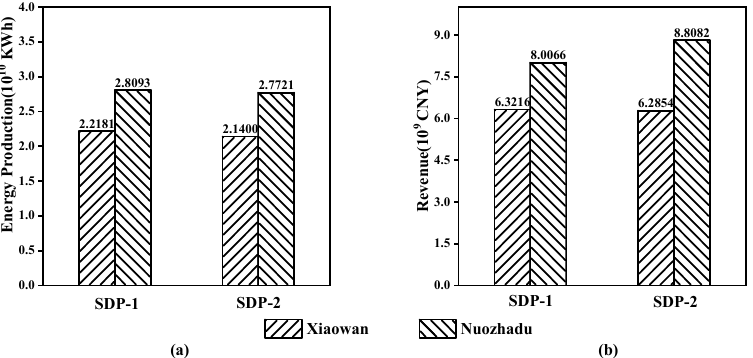
Figure 4. Comparison between the SDP-1 and SDP-2 on expected energy ( a ) and revenue ( b ).